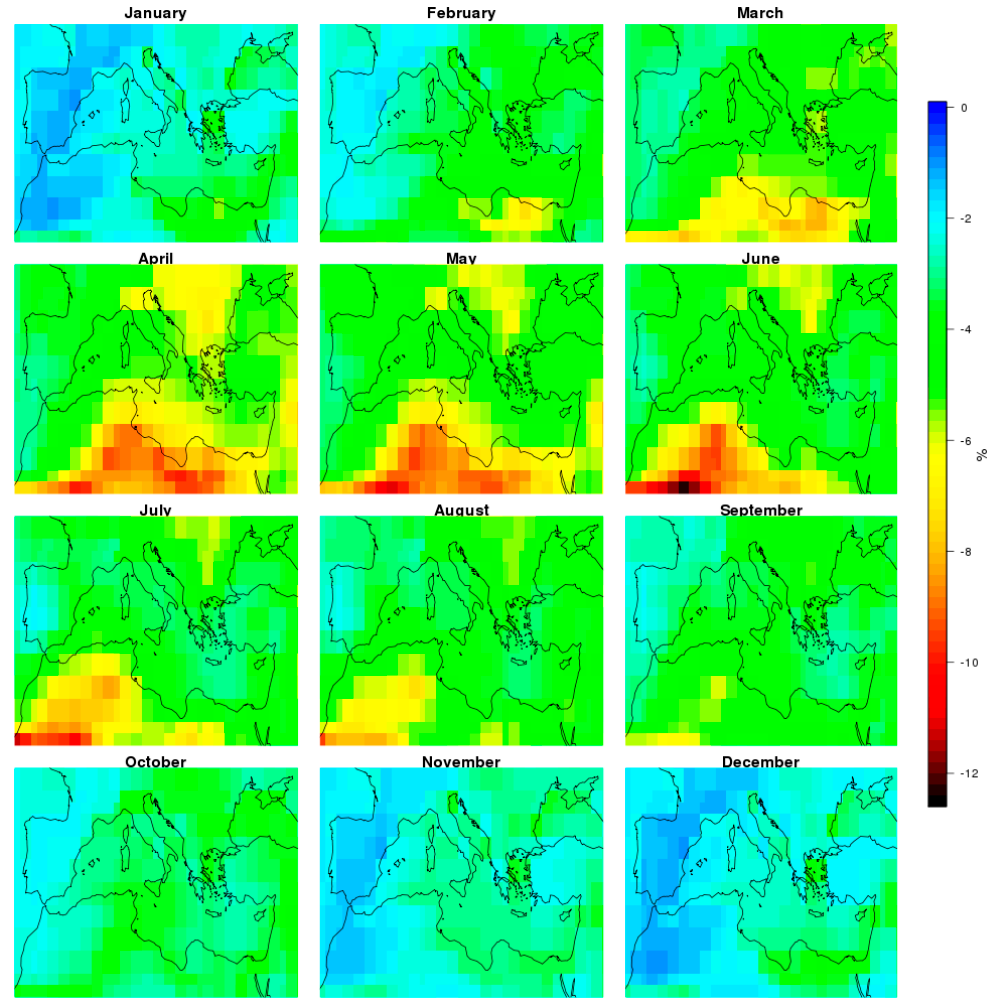
Figure 2. Distribution of monthly averaged AOT effects on shortwave radiation at the surface over the Mediterranean basin during the period 2000–2018. All figures have the same scale.